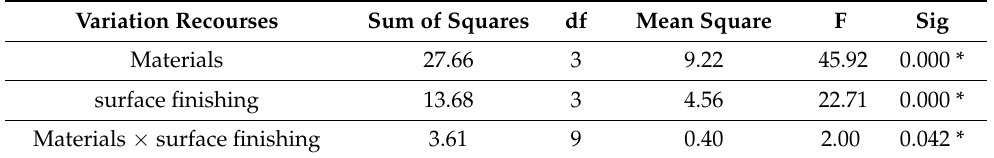
Table 3. MANOVA of ∆ E.